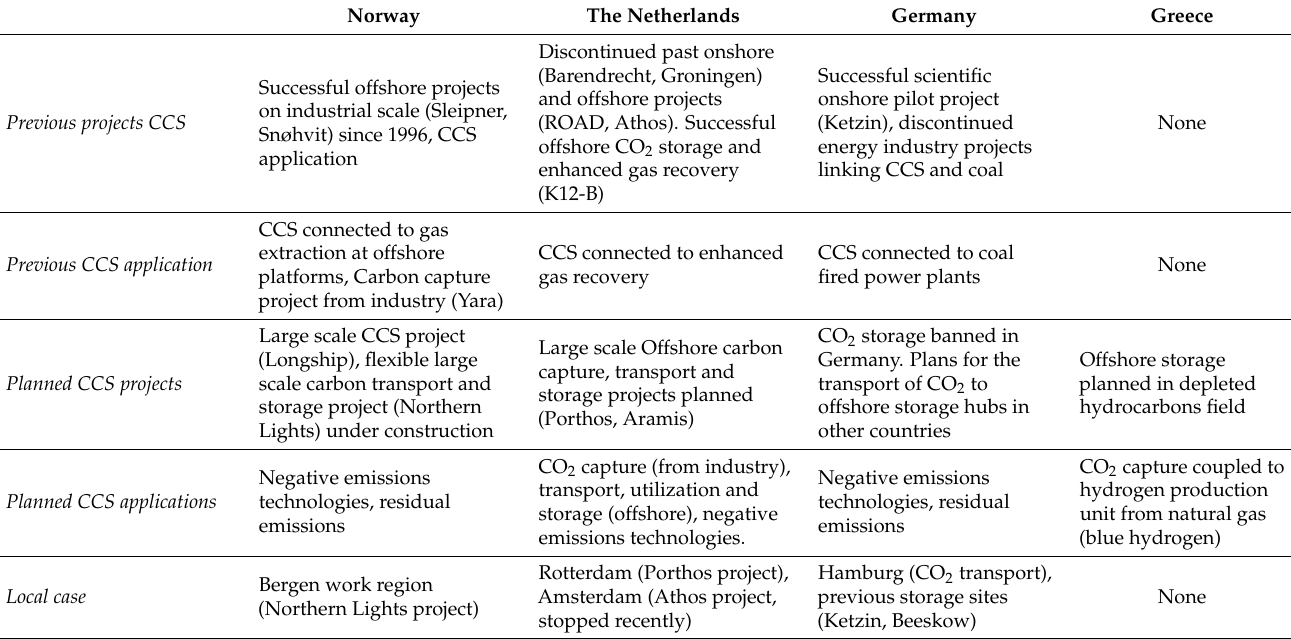
Table 1. Country-specific contexts of